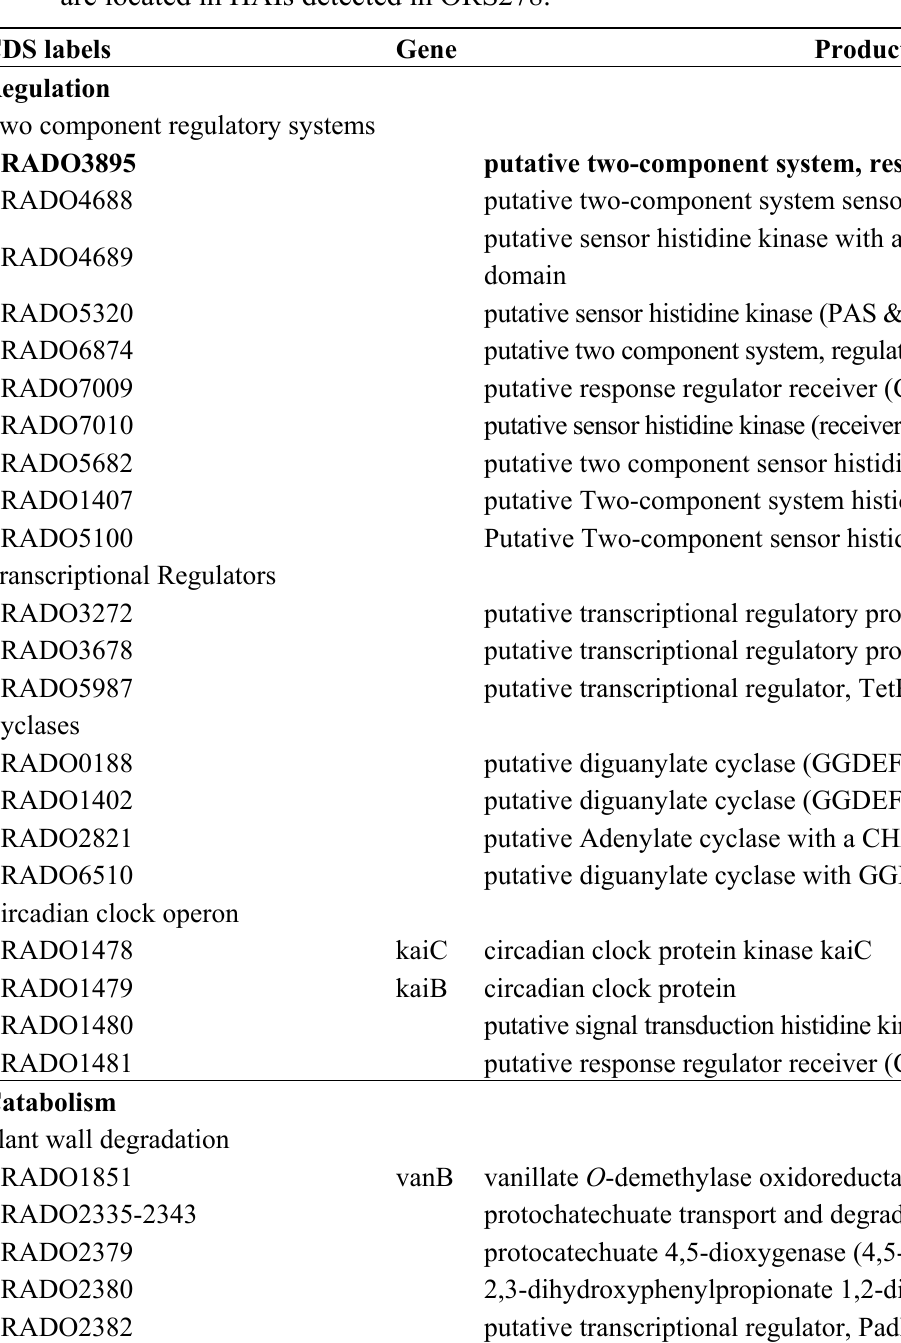
Table 3. List of specific annotated genes in nod-independent bradyrhizobia. Genes in bold are located in HAIs detected in